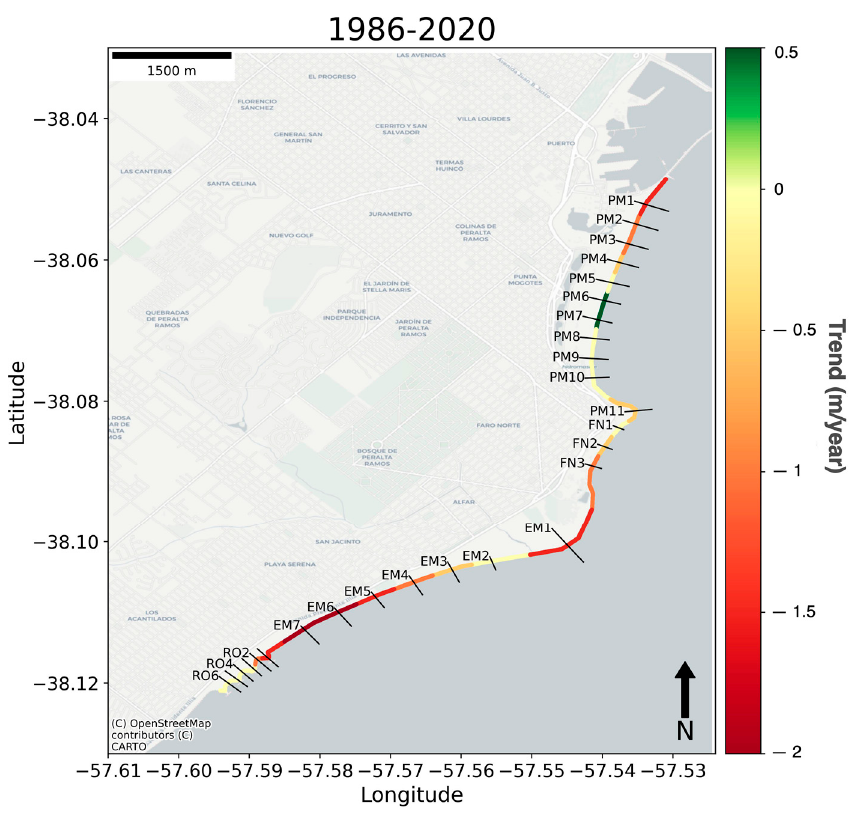
Figure 8. BWV long-term trends in m/year, 1986–2020. Negative trends are indicated by reddish colors and positive trends by greenish colors. Transects locations and names are indicated.